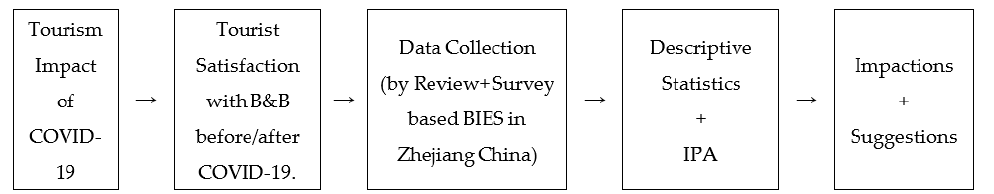
Figure 1. The logical model. Notes: B&B = Bed and Breakfast, BIES = B & B industry evaluation